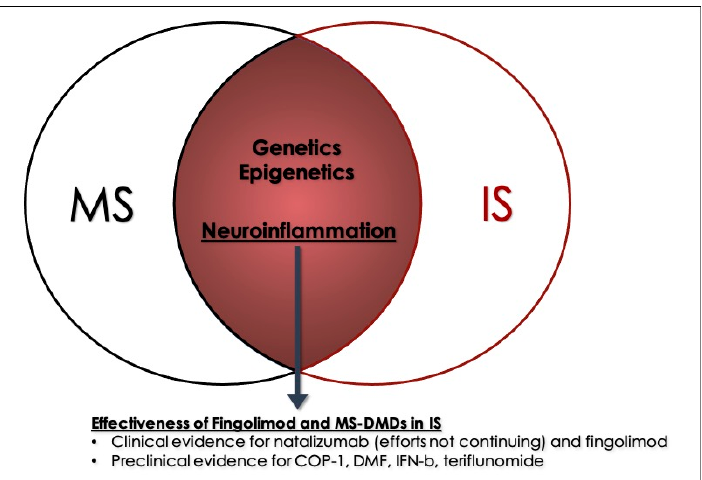
Figure 2. Neuroinflammation, the overlap between Multiple Sclerosis (MS) and Ischemic Stroke (IS) gives way to the application of MS-disease-modifying drugs to be applied in cerebral ischemia.